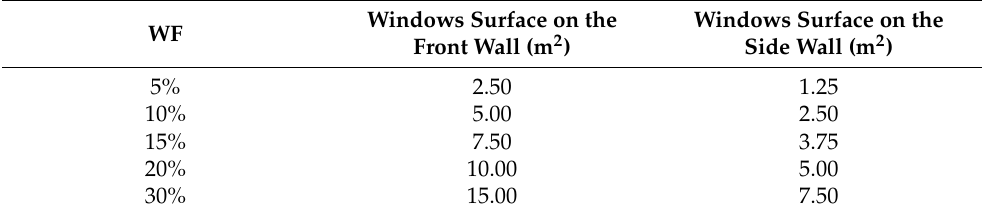
Table 7. Surface of windows in each wall for 100-2-x-0